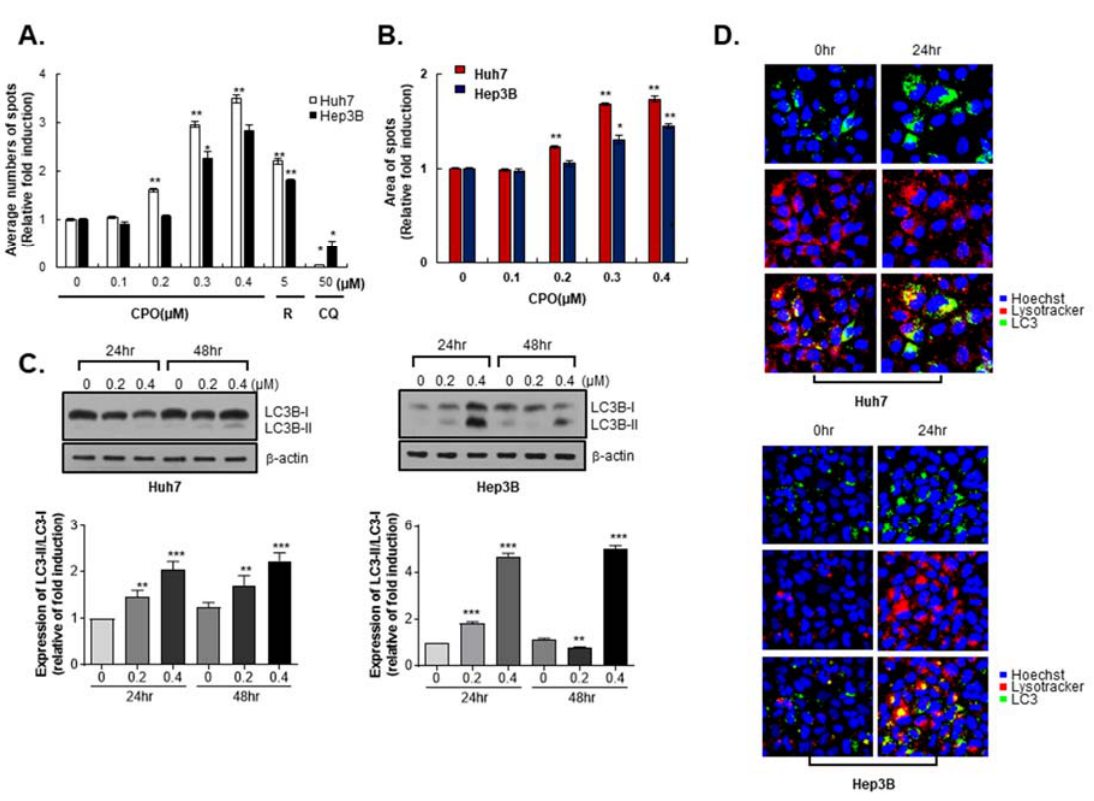
Figure 3. Autophagy in hepatocellular carcinoma (HCC) induced by chromenopyrimidinone (CPO). ( A ) Average numbers of autophagosome spots after treating Huh7 and Hep3B cells with the indicated concentration of CPO for 48 h. Rapamycin (R) was used to induce autophagy, and chloroquine (CQ) was used to inhibit autophagy. ( B ) The area of autophagosome spots after treating Huh7 and Hep3B cells with the indicated concentration of CPO for 48 h. ( C ) Expression of LC3B-I and LC3B-II after treat Huh7 (left panel) and Hep3B cells (right panel) with or without 200 nM or 400 nM CPO for 24 h or 48 h (upper panel). Expression of proteins was quantified (lower panel). β -actin was used as the control (whole blot image, Figure S3). ( D ) Immunocytochemistry images of LysoTracker (red) for detecting lysosomes, LC3 (green), and the nucleus (blue) after treating Huh7 (upper panel) and Hep3B cells (lower panel) with 200 nM CPO for 24 h. Images were acquired using an HCS system with a 40 × objective. The data shown are from three independent experiments relative to the control values and the mean values ± SD from three independent experiments; * p < 0.05, ** p < 0.01 and *** p < 0.001 compared to control group.